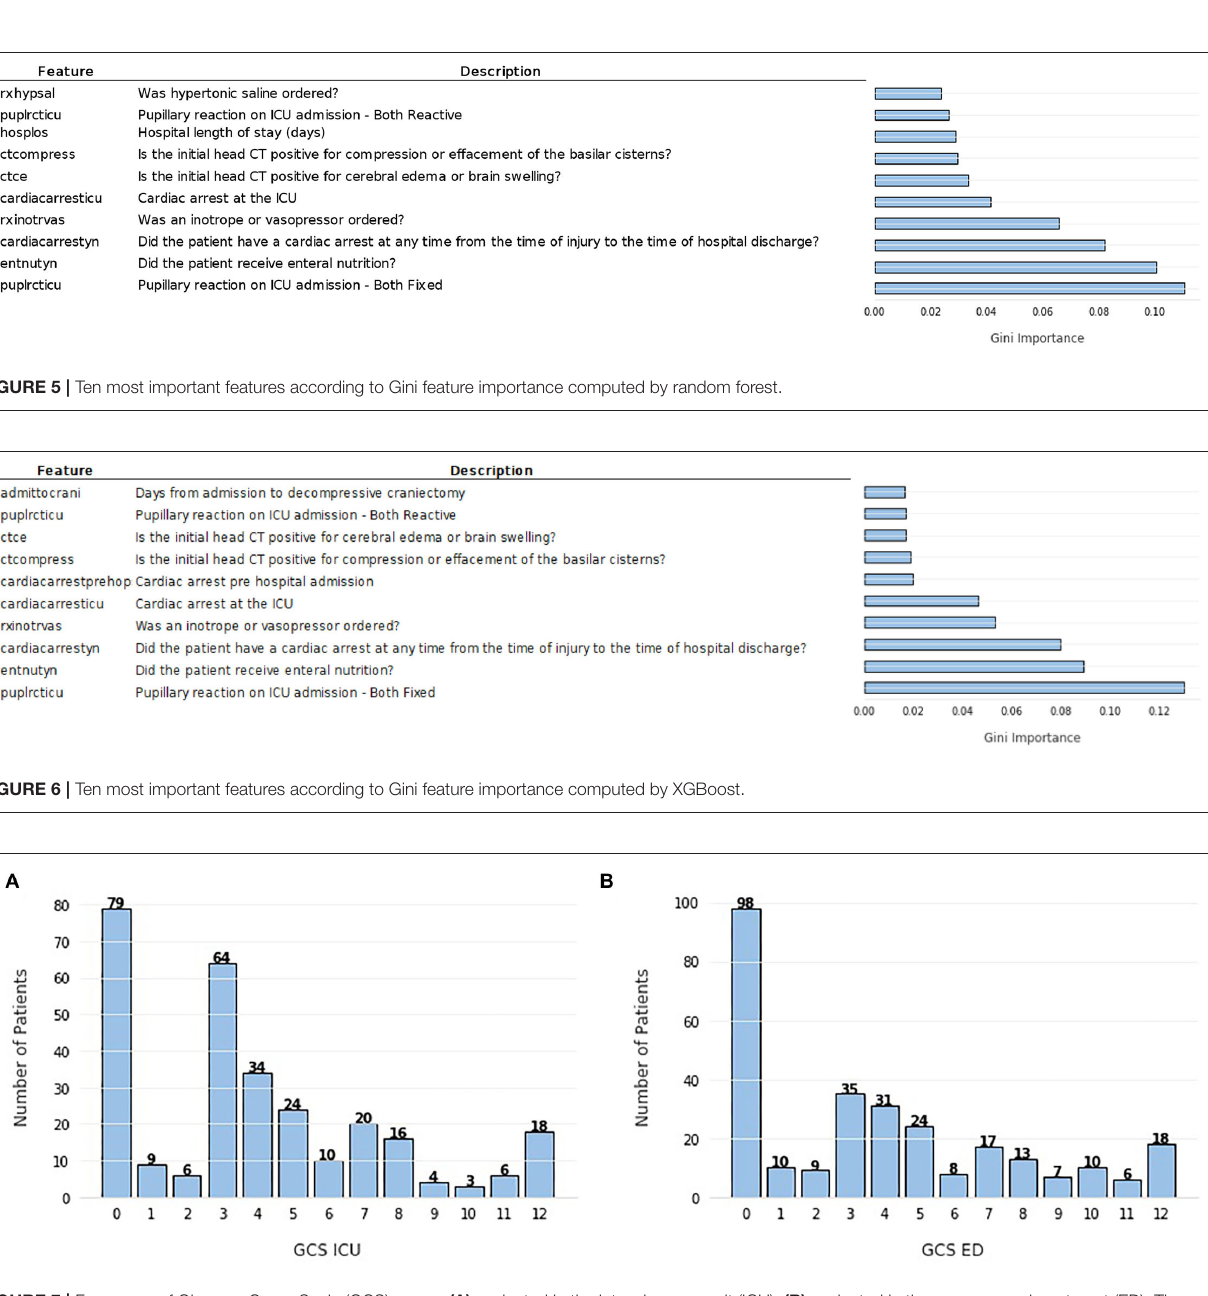
FIGURE 7 | Frequency of Glasgow Coma Scale (GCS) scores (A) evaluated in the intensive care unit (ICU), (B) evaluated in the emergency department (ED). The scores range from 3 (completely unresponsive) to 15 (completely